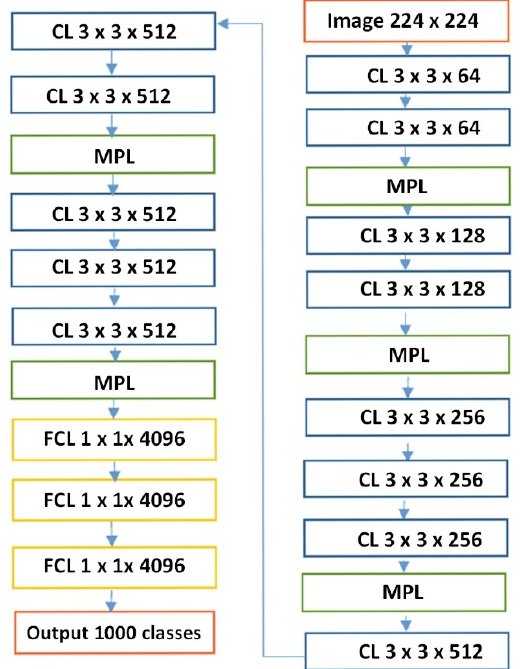
Figure 9. Architecture of the VGG16 neural network. CL is the convolution layer, and MPL is the maximum pooling layer.